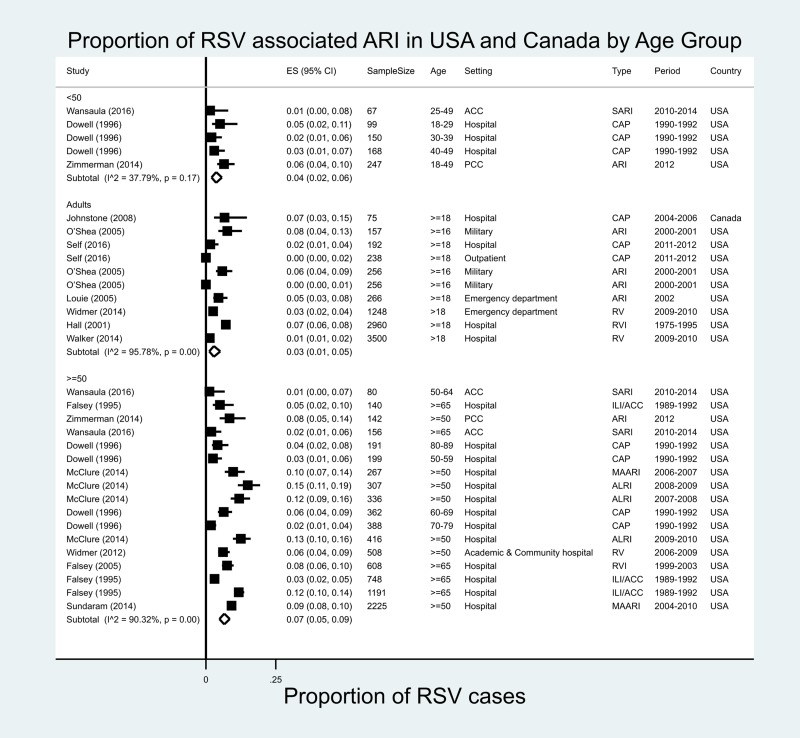
Proportion of RSV among ARI/ILI in adults in the USA and Canada.